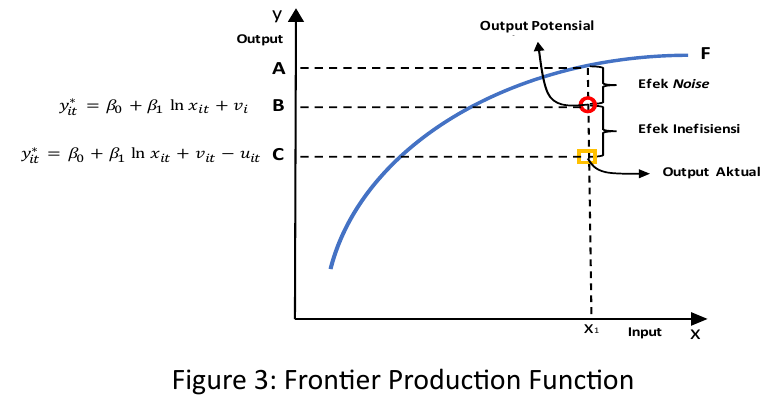
Figure 3: Frontier Production